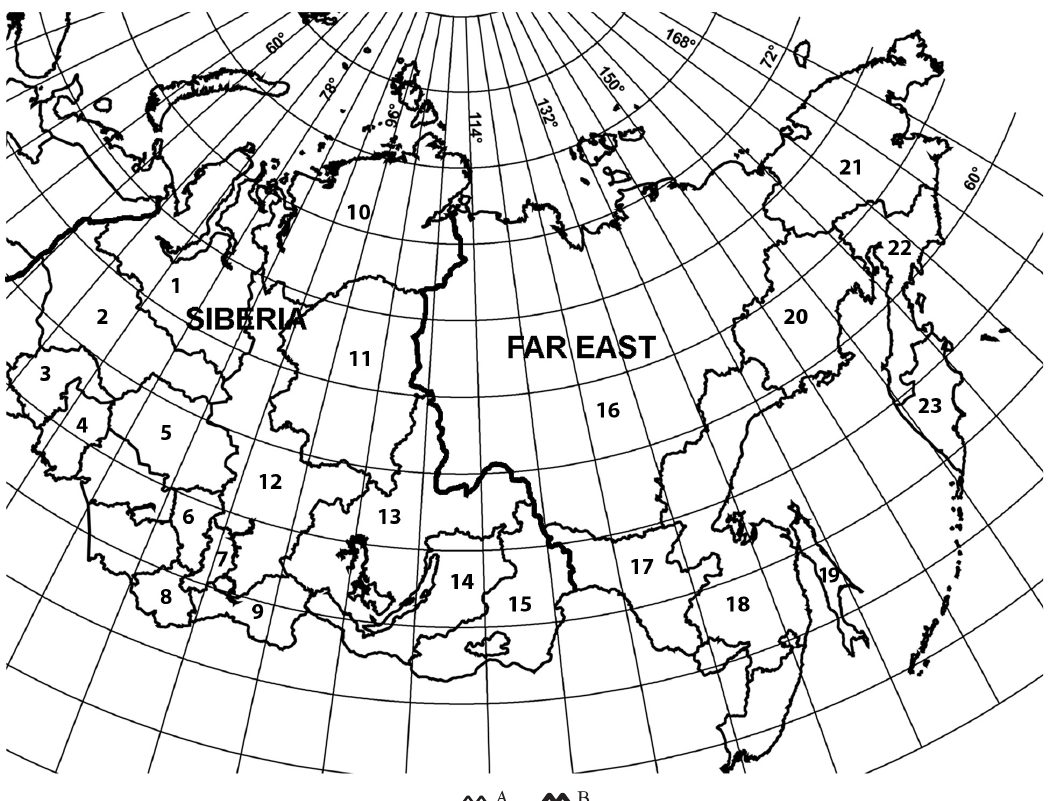
A Fig. 1. Map of Russia, showing the geographical locations of Siberia and the Far East of Russia. A: borders of adminis- trative regions; B: Siberian and Far East border. Administrative regions with wild and feral reindeer are 1 Yamalo-Nenetsky AO; 2 Khanty-Mansiysky AO; 3 Tumenskaya oblast; 4 Omskaya oblast; 5 Tomskaya oblast; 6 Kemerovskaya oblast; 7 The Republic of Khakasia; 8 The Republic of Altay; 9 The Republic of Tyva; 10 Taimyrsky AO; 11 Evenksky AO; 12 Krasnoyarsky krai; 13 Irkutskaya oblast; 14 The Republic of Buryatia; 15 Chitinskaya oblast; 16 The Republic of Sakha (Yakutia); 17 Amurskaya oblast; 18 Khabarovsky krai; 19 Sakhalinskaya oblast: 20 Magadanskaya oblast; 21 Chukotsky AO; 22 Koryaksky AO; 23 Kamchatskaya oblast.